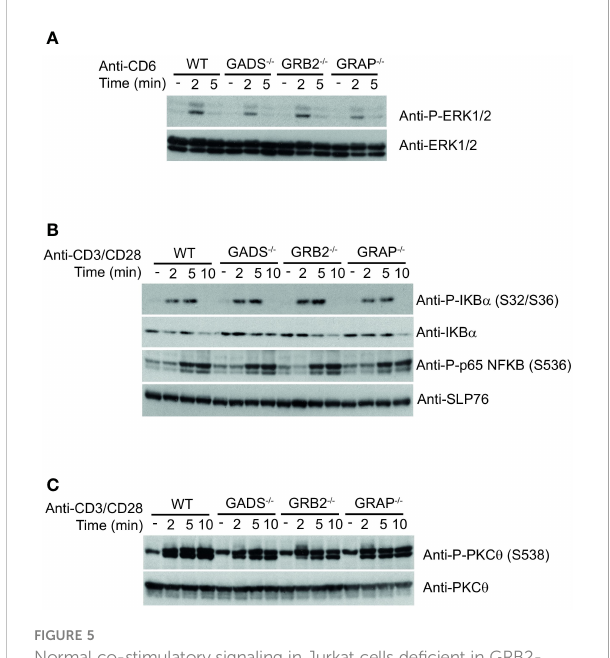
FIGURE 5 Normal co-stimulatory signaling in Jurkat cells de fi cient in GRB2- family adaptors. (A) WT, GADS -/- , GRB2 -/- and GRAP -/- Jurkat cells were left unstimulated (-) or stimulated for 2 or 5 min with anti-CD6 antibody. Equal amounts of protein lysates were analyzed by immunoblot with phospho-speci fi c ERK1/2 antibody and with anti- ERK1/2 antibody. (B) Same cells as in A were left unstimulated (-) or stimulated for 2, 5 or 10 min with anti-CD3 and anti-CD28 antibodies. Equal amounts of protein lysates were analyzed by immunoblot with indicated phospho-speci fi c antibodies and loading control was assessed with anti-SLP76 antibody. (C) Analysis of the PKC q phosphorylation in cells and experimental conditions described in (B) . Data are representative of at least two independent